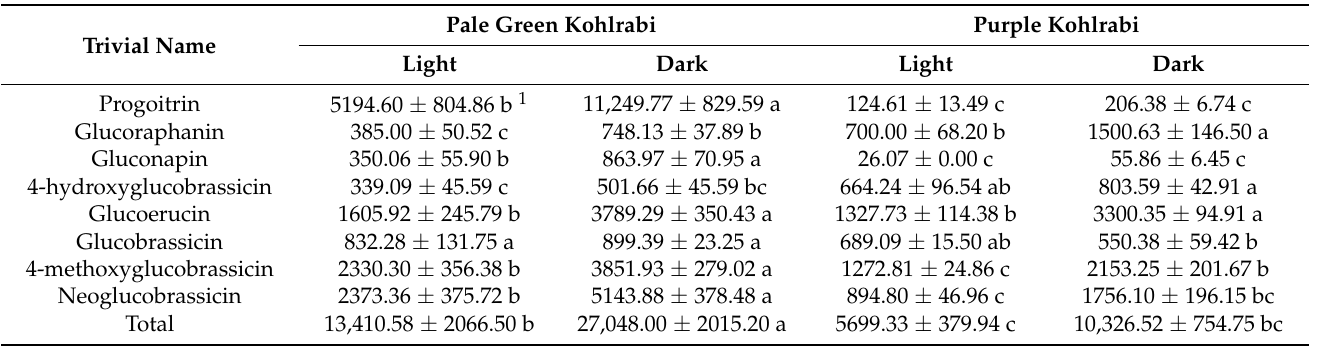
Table 2. Accumulation of glucosinolates ( µ g/g DW) during the sprout development of pale green and purple kohlrabi under dark and light